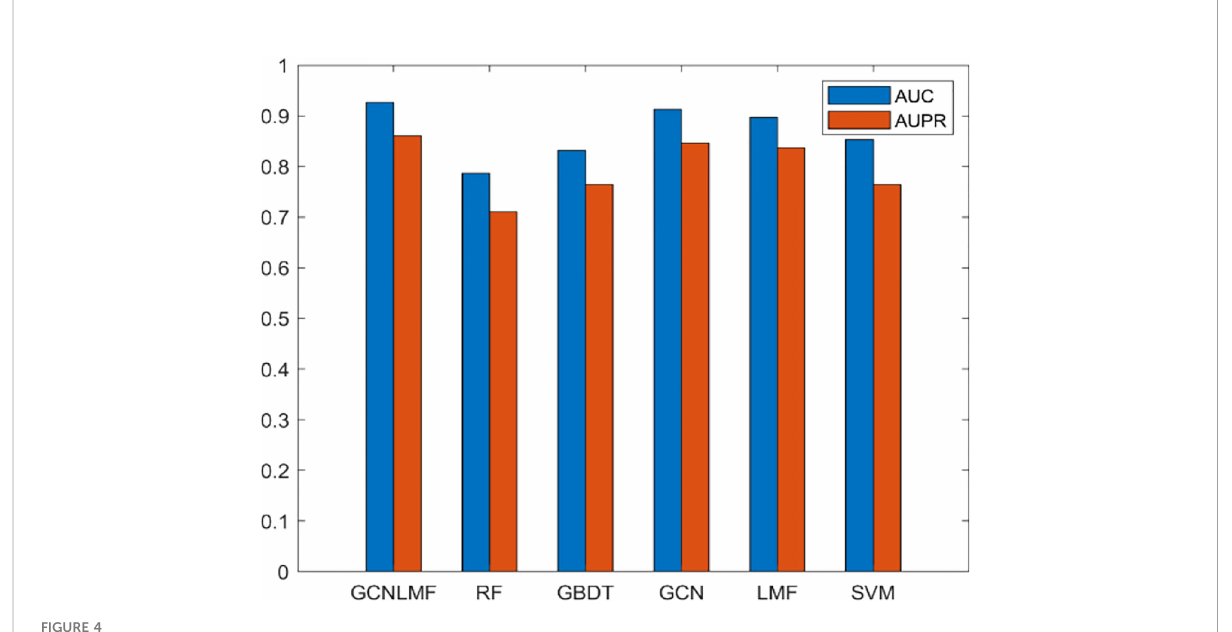
FIGURE 4 Results of GCNLMF compared to the other fi ve